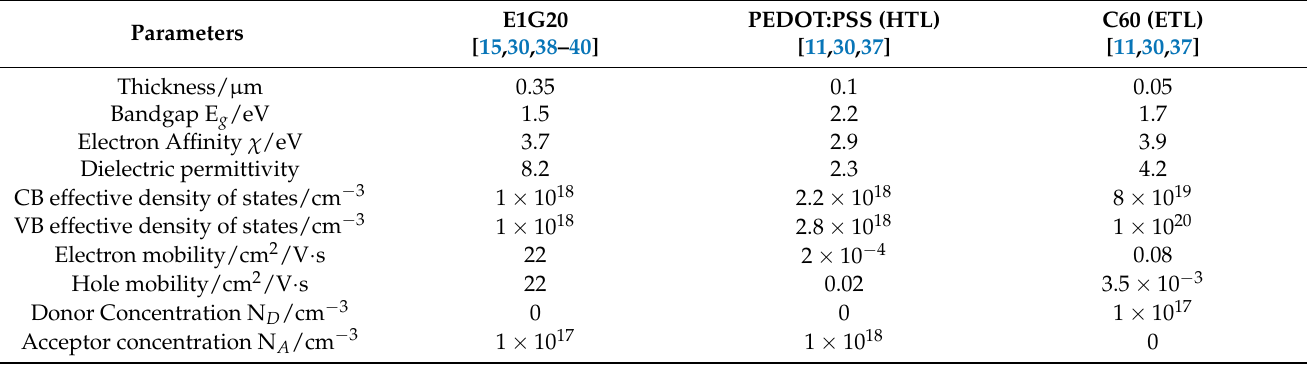
Table 1. Electrical and optical properties used in simulation of GAFASnI 3 -based perovskite solar cell.